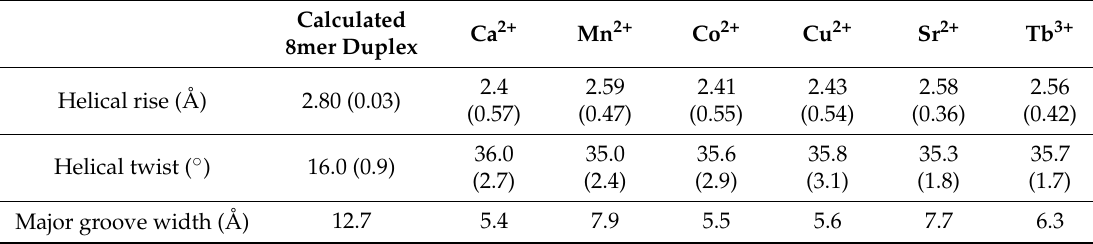
Figure 1. Effects of the nature of the metal ion on RNA structure. ( a ) Overlay of all octameric RNA crystal structures in the presence of Ca 2+ ( green ), Mn 2+ ( purple ), Sr 2+ ( grey ), Tb 3+ ( yellow ), Cu 2+ ( brown ), and Co 2+ ( pink ); ( b ) Calculated, energy-minimized octameric A-RNA duplex ( grey ) in solution compared to the X-ray structure solved in the presence of Ca 2+ ( red ). The energy-minimized octameric A-RNA duplex was calculated with the program RNAComposer [28]; ( c ) end-on-end stacking of individual octamers (shown in three different colors) in the crystal structure. Table 1. Selected helical parameters calculated with the program X3DNA [27]. The average values of all local base-pair values are provided together with the standard deviation as defined by the program X3DNA (in parentheses).